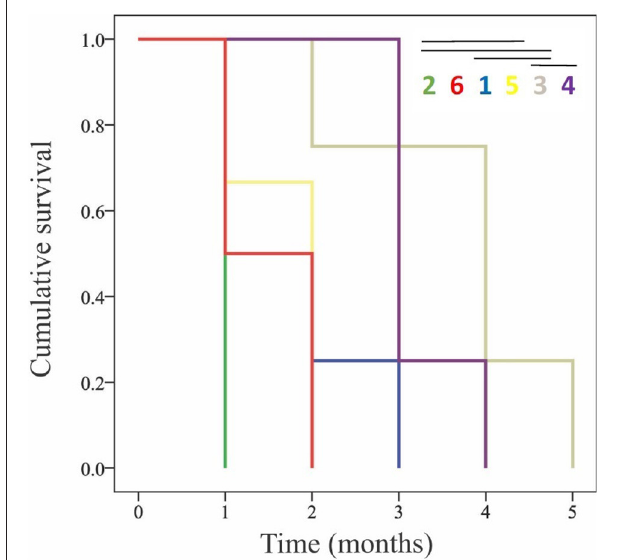
FIGURE 4 | Kaplan-Meier cumulative survival curves for the long-term experiment showing the month when the different genotypes reached negative net calcification (dissolution). Each color represents a different genotype, with no significant difference among pairwise comparisons of the times that they could maintain positive calcification indicated by the lines over the numbers in the